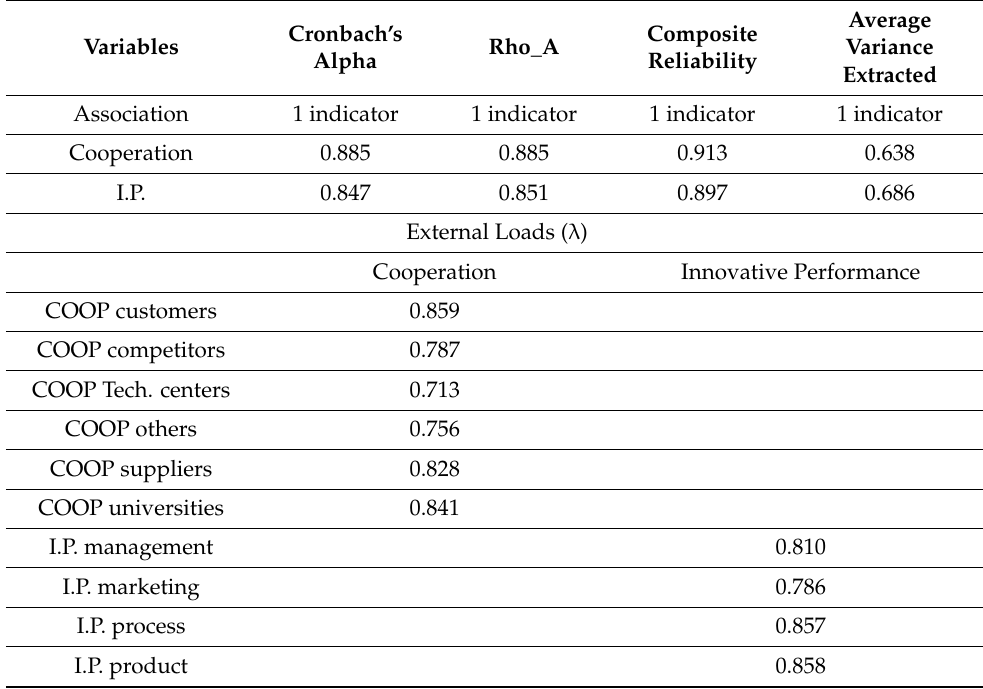
Table 4. Assessment of internal consistency and convergent validity.